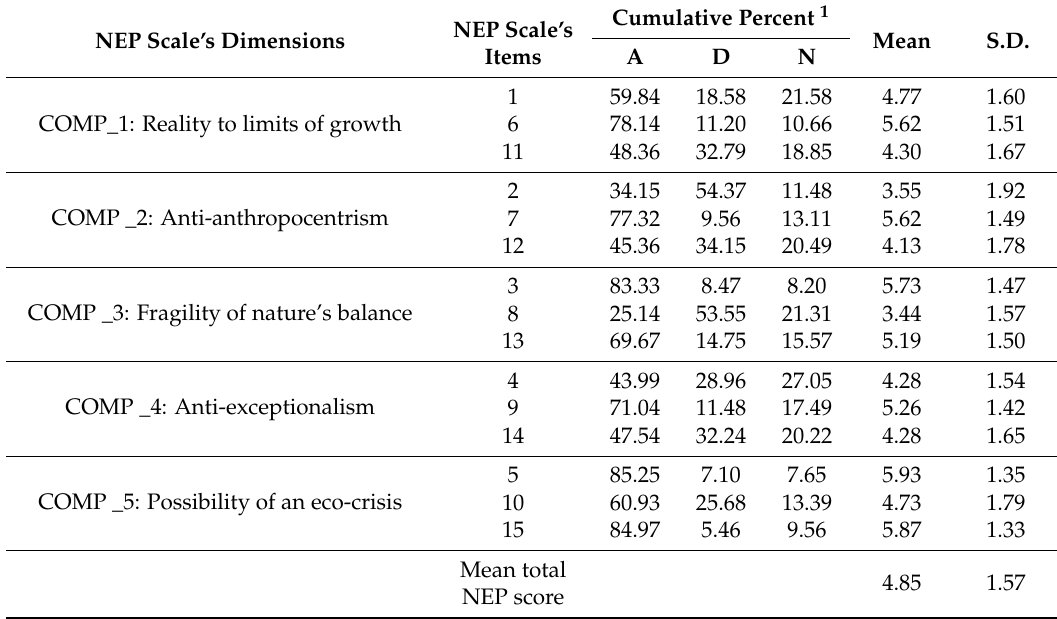
Table 4. Responses concerning New Environmental Paradigm Scale (NEP)